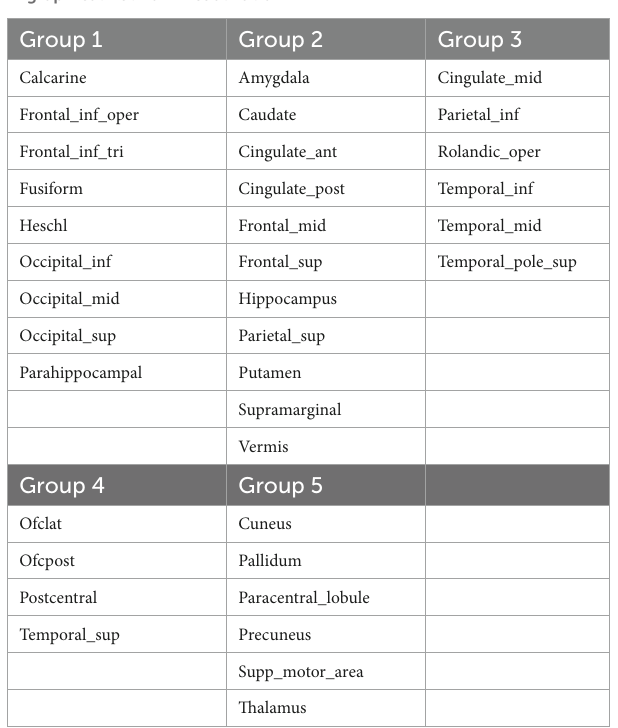
TABLE 4 Distribution of brain regions between modularity cluster groups in graphical network